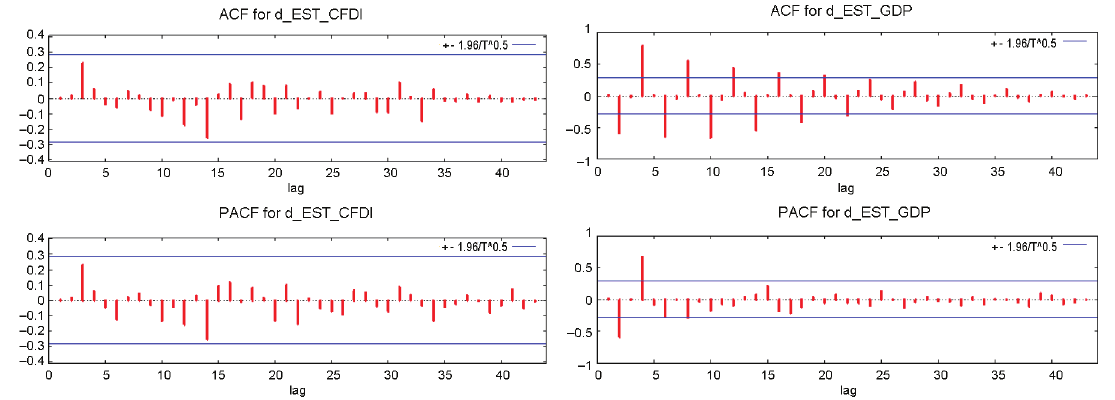
Fig. 13. Time series plots of the first-order integration autocorrelation function (ACF) and partial autocorrelation function (PACF) for Estonia’s CFDI and the construction’s contribution to